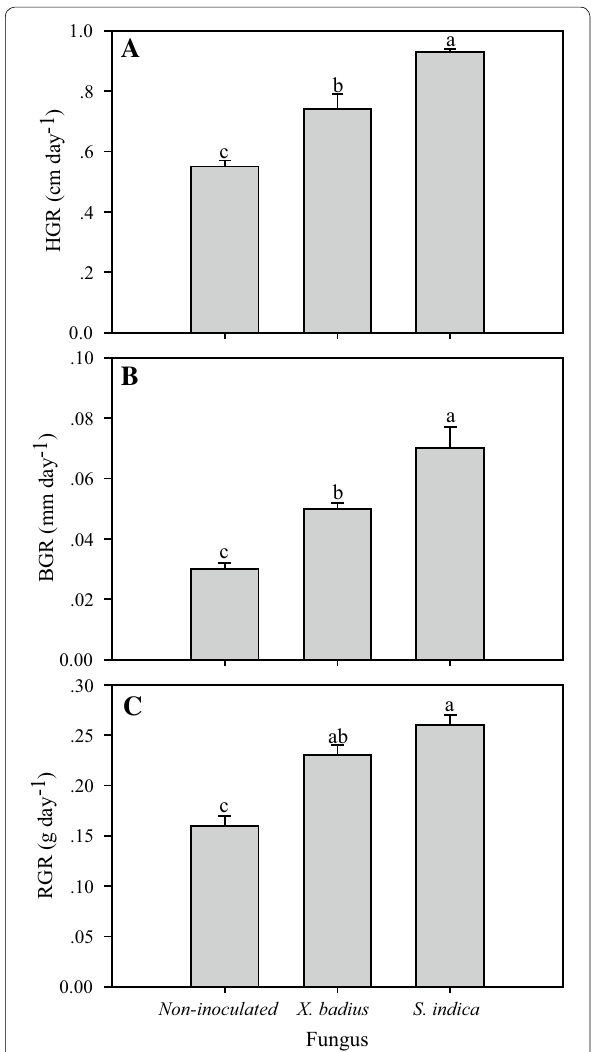
Fig. 5 Effect of X. badius and S. indica inoculation on HGR ( A ), BGR ( B ), and RGR ( C ) of L. multiflorum seedlings. BGR: relative basal diameter growth rate, HGR: relative height growth rate, RGR: relative growth rate. Values are means of six replicates. Bars represent the standard deviation. Lowercases show statistically significant differences for the same parameter among L. multiflorum seedlings inoculated by X.